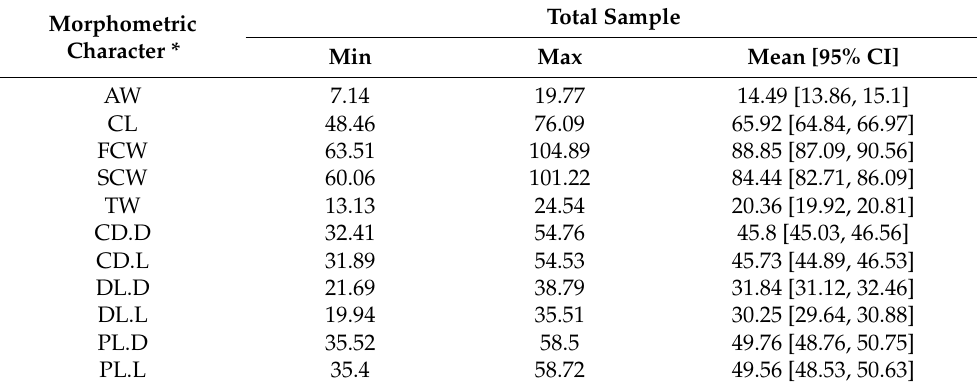
Table 1. Minimum (min), maximum (max) and mean values with lower and upper limits of 95% confidence intervals [95% CI] for morphometric characters (mm) of Calappa granulata (N = 92) from the central eastern Adriatic